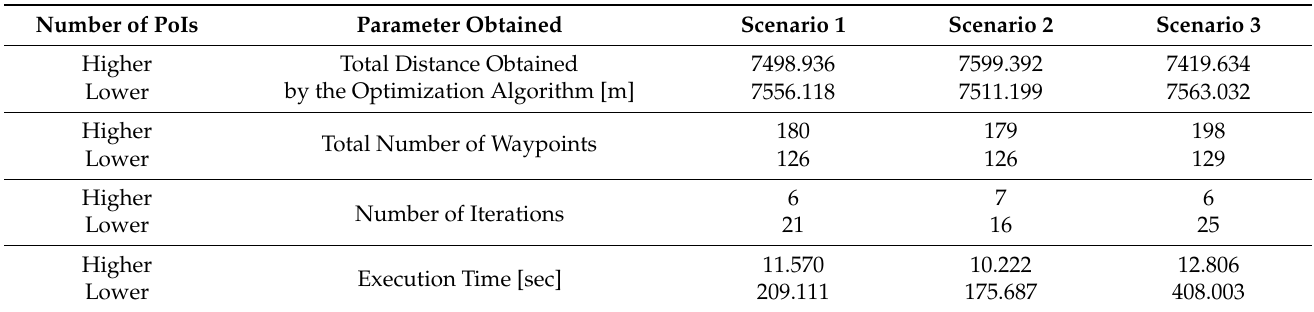
Table 7. Average results from Case Study